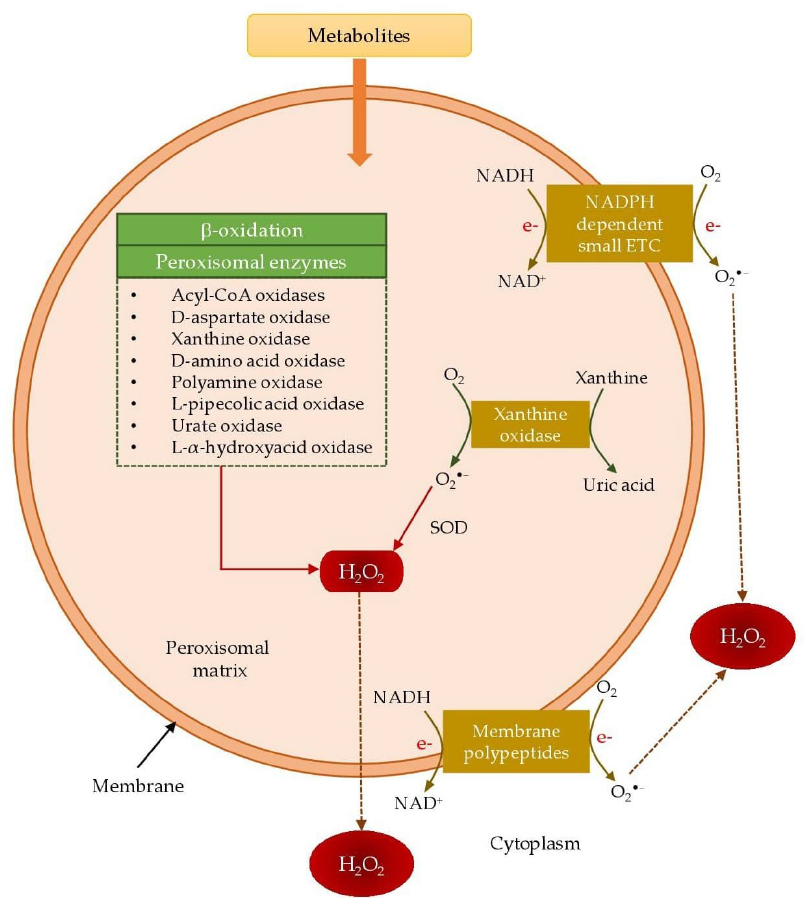
Figure 7. Process of H 2 O 2 and O 2 •− generation by the peroxisomes. The chief metabolic process that produces H 2 O 2 in the peroxisome is the β -oxidation of fatty acids. Additionally, various peroxisome enzymes produce H 2 O 2 as a part of their normal catalytic cycle. Moreover, NADPH dependent small ETC, xanthine oxidase, and membrane polypeptides produce O 2 •− anions, which are further converted to H 2 O 2 .